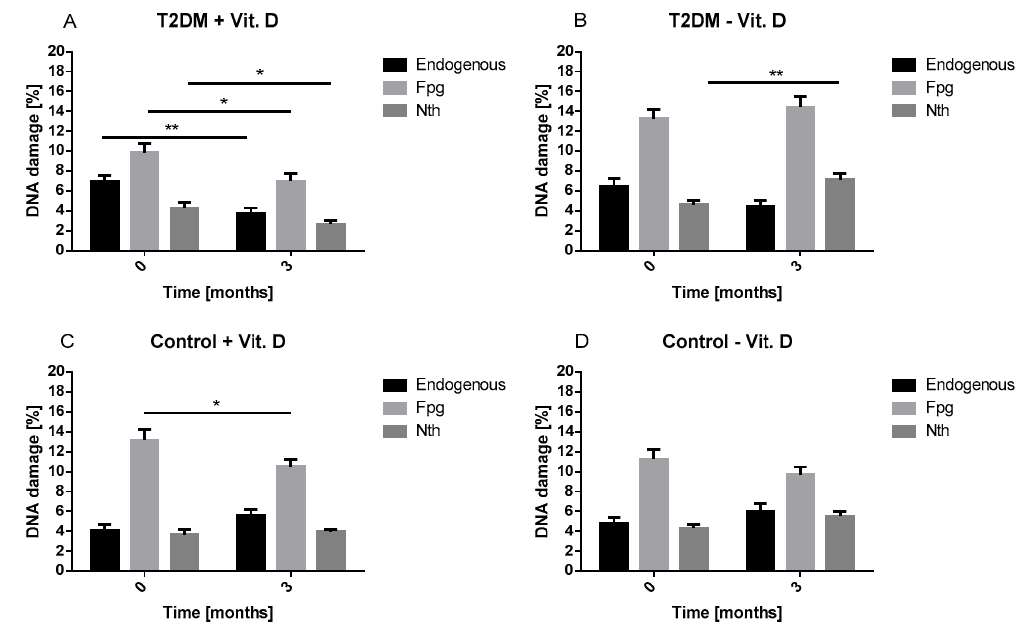
Figure 4. The impact of three-month supplementation with vitamin D on the level of endogenous and oxidative DNA damage. DNA damage were determined in ( A ) T2DM patients treated with vitamin D (T2DM + Vit. D, n = 14), ( B ) T2DM patients not treated with vitamin D (T2DM − Vit. D, n = 18), ( C ) patients without T2DM treated with vitamin D (Control + Vit.D, n = 30), ( D ) patients without T2DM not treated with vitamin D (Control − Vit. D, n = 30). The level of DNA damage was measured by the alkaline comet assay. Data are expressed as mean ± SEM. * p < 0.05; ** p < 0.01